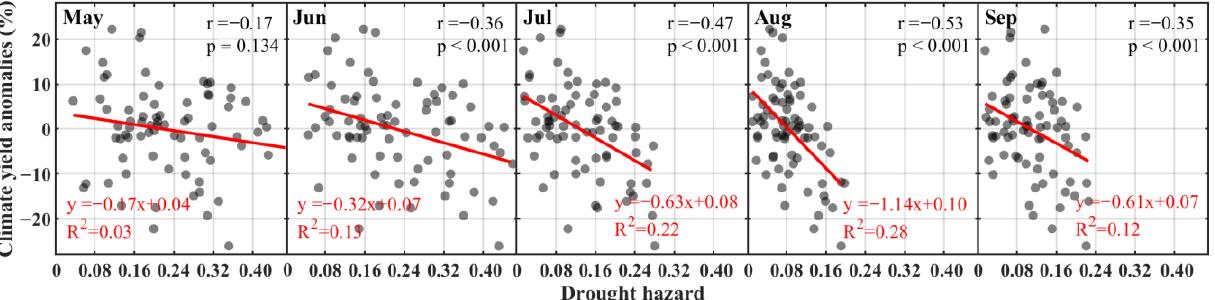
Figure 12. Linear relationship between climatic yield anomalies and drought hazard during the growing season for maize in NEC.